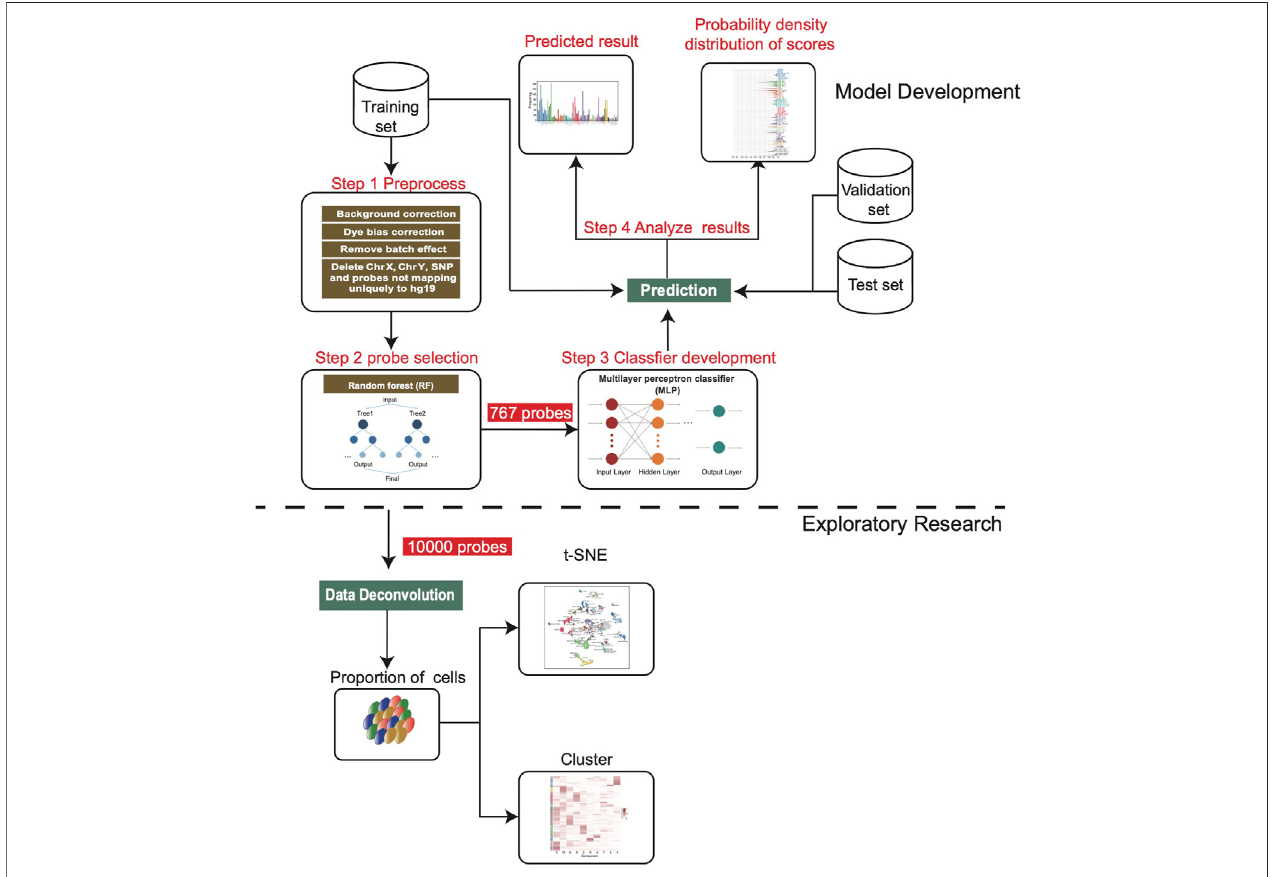
FIGURE 1 | Work fl ow chart ofthis study. After the training set was preprocessed, we screened 767 features to develop the MLP model, and then applied it on the validation set and independent test set. In addition, 10,000 features were screened for deconvolution analysis to estimate the cell composition of each sample.